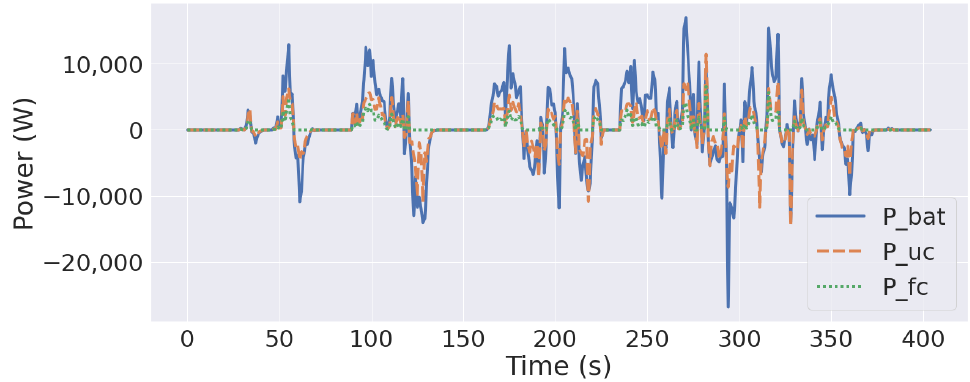
Figure 17. Actual battery, ultracapacitor and fuel cell powers by DRL.